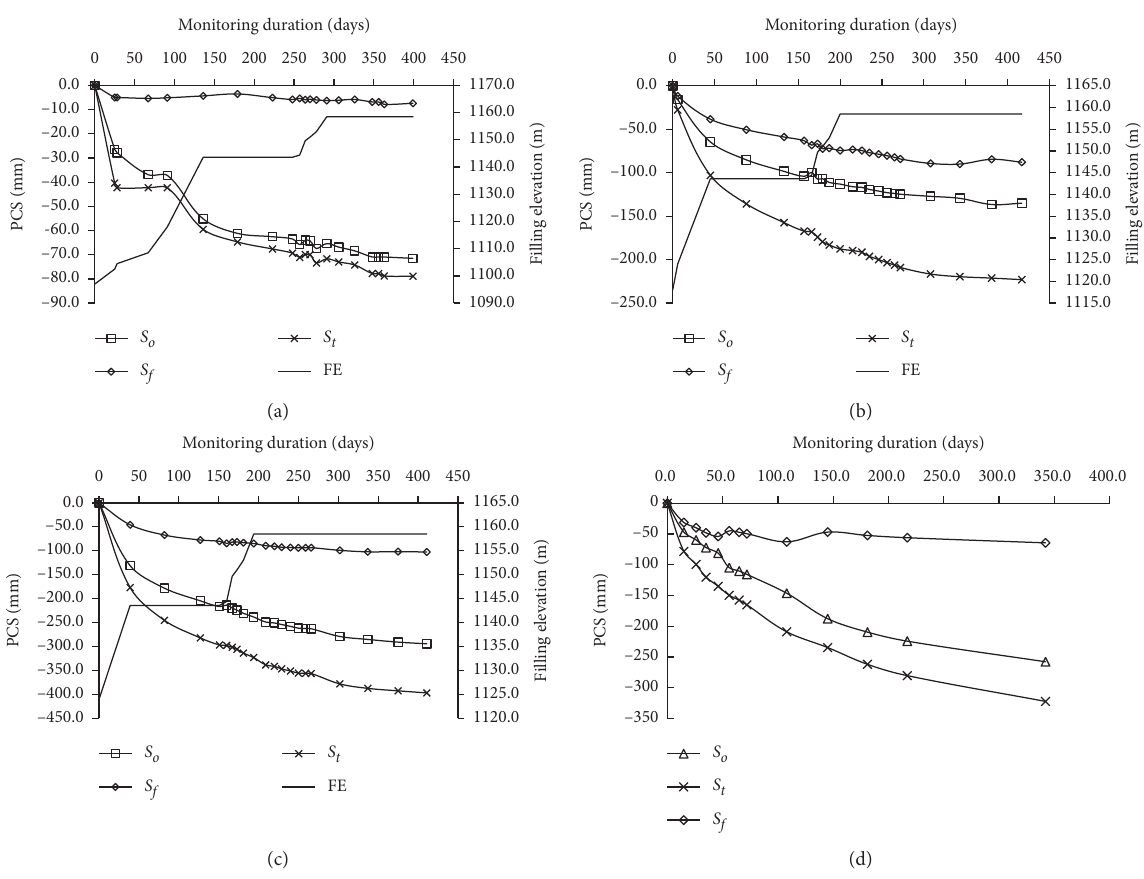
Figure 12: PCS versus monitoring date curves of surface and foundation. (a) No. 2 platform (1077.0m). (b) No. 5 platform (1107.0m). (c) No. 6 platform (1117.0m). (d) Top of the high fill